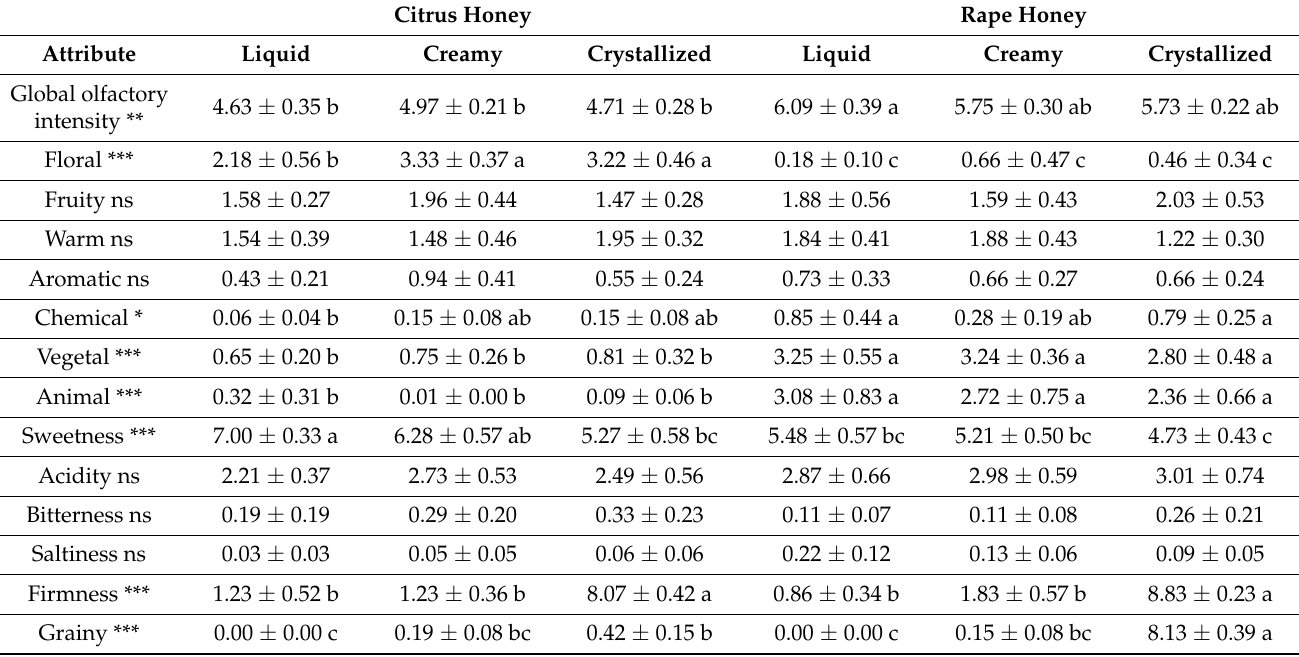
Table 4. Sensory characterization by the expert